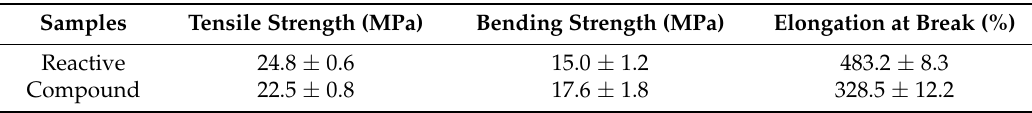
Table 6. The tensile strength, bending strength and elongation at break of EPDM/PP composites with 25%wt reactive and compound MP/PER